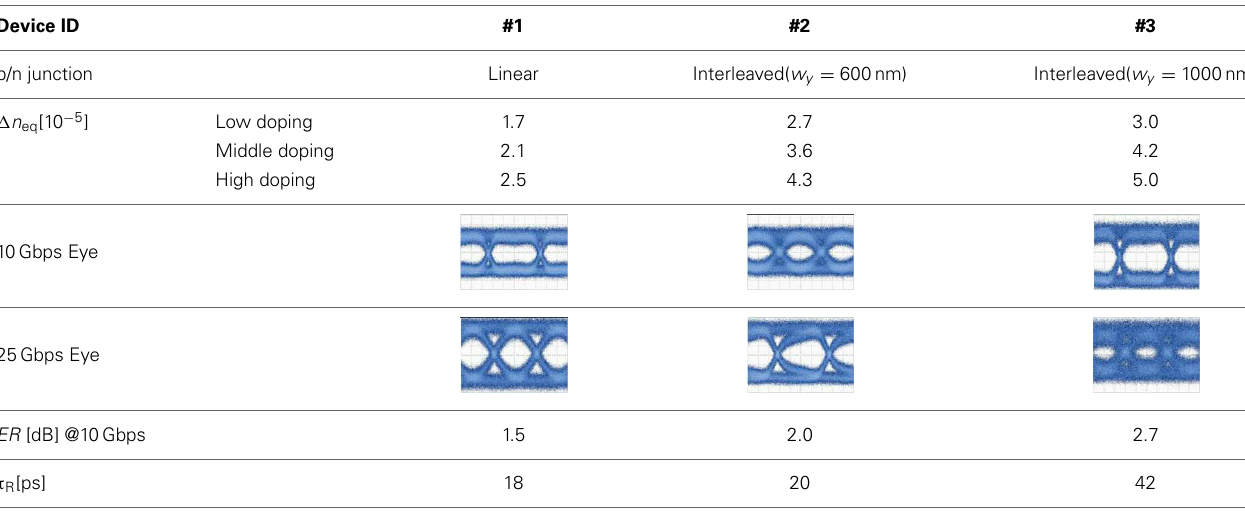
Table 3 | Comparison of performance between three p/n junctions.